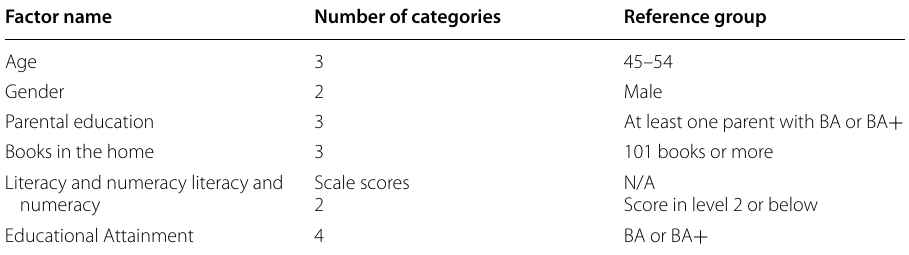
Table 1 Factors employed in analyses, the number of categories corresponding to each factor and the reference group used in regression analyses (if